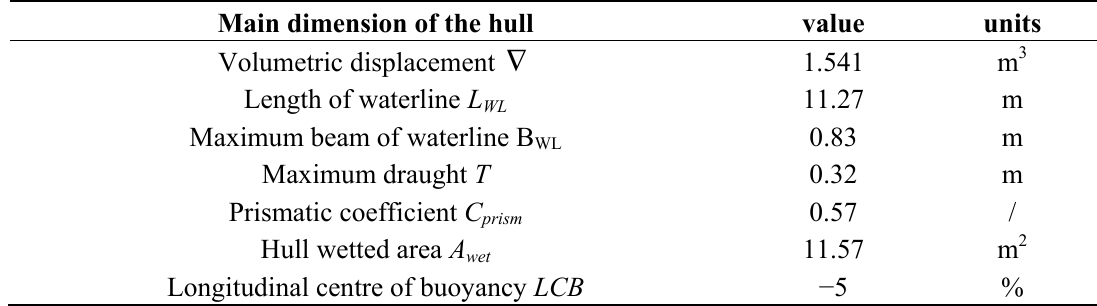
Table 2. The main dimensions of one hull of the